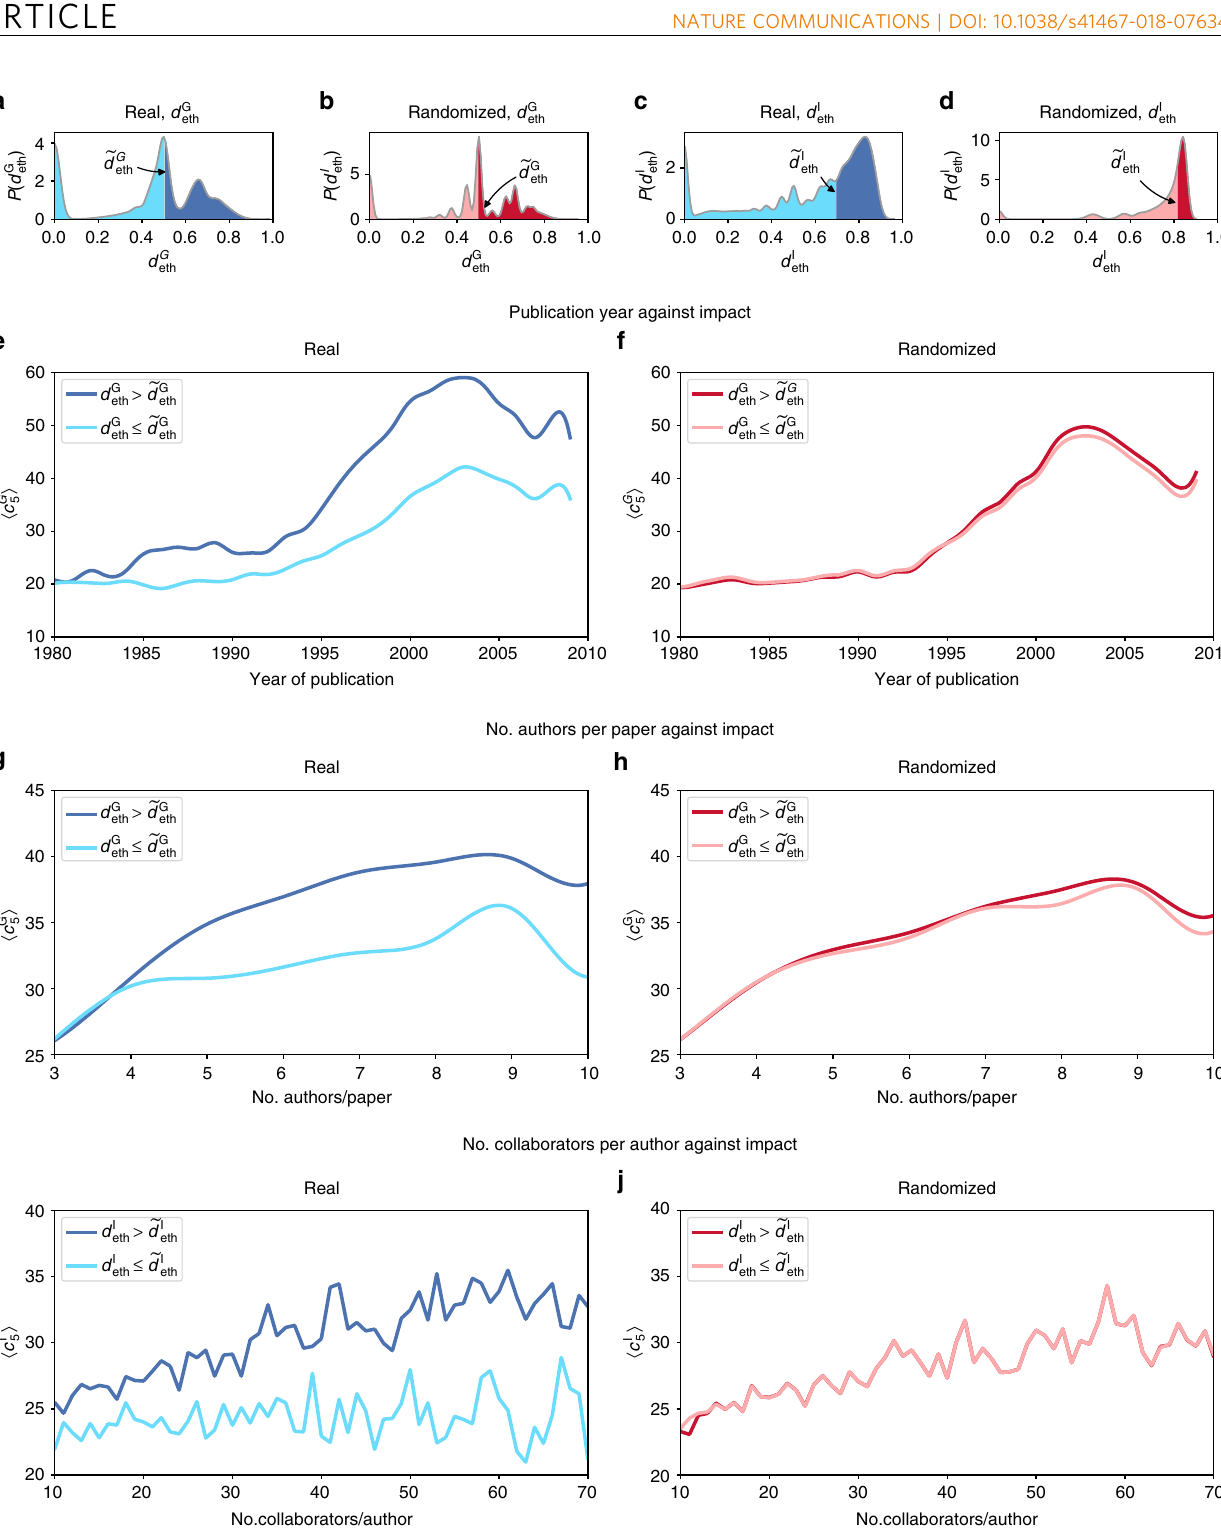
Fig. 4 The relationship between ethnic diversity and impact. a Distribution of d G (highlighted in the darker tones, with d G b The same as ( a ), but for randomized data. c and d The same as ( a , b ), respectively, but with d I data. f The same as ( e ), but for randomized data. g h c G against number of collaborators per scientist in real data. j The same as ( i ), but for randomized